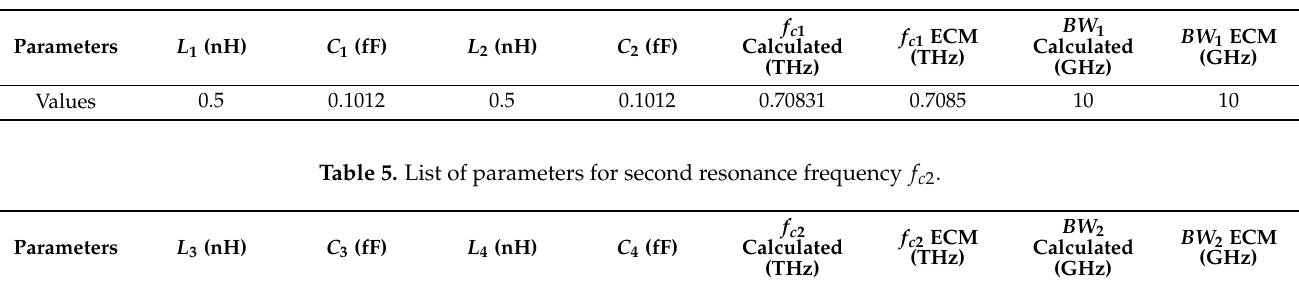
Table 4. List of parameters for first resonance frequency f c 1 .